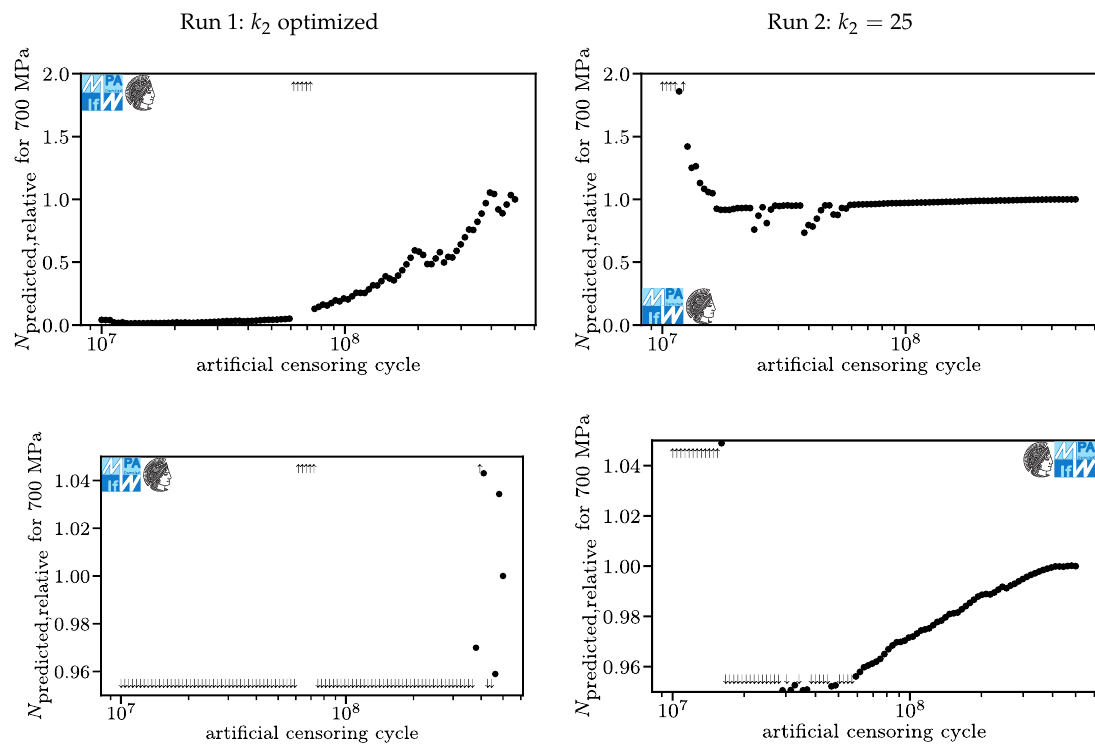
Figure 12. Lifetime predictions for Run 1 ( left ) and Run 2 ( right ), overview and detail for stroke stresses of 700